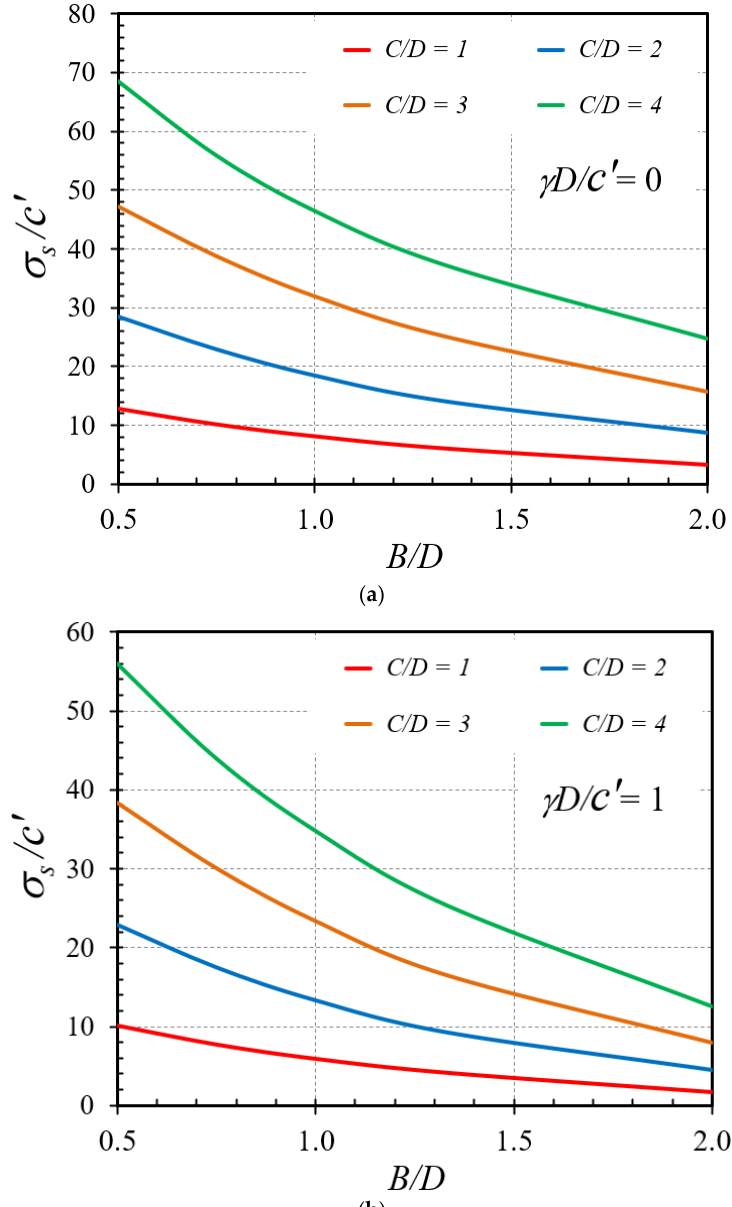
Figure 5. Influence of C/D on the stability factors σ s /c' of horseshoe tunnels with ϕ = 25°: ( a ) γ D/c' = 0 and ( b ) γ D/c' = 1.